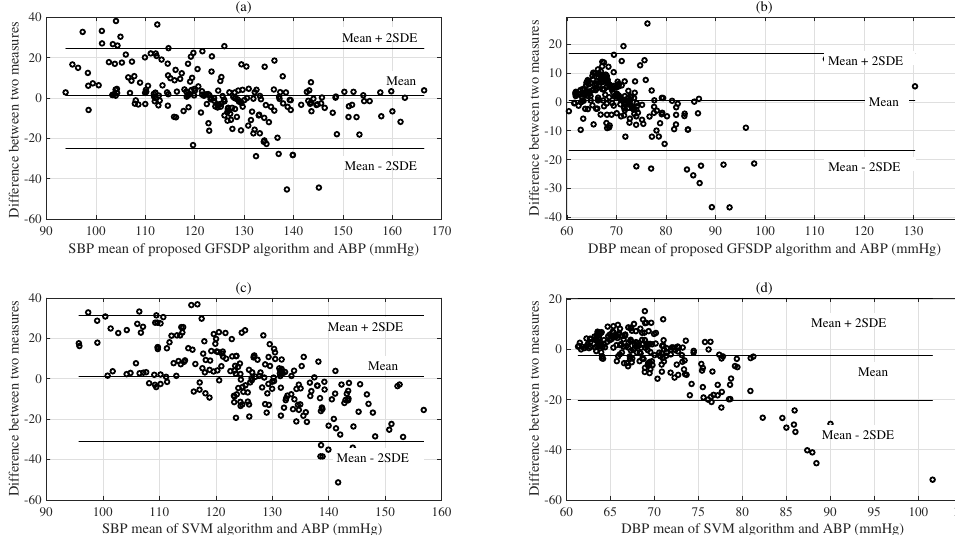
Figure 5. We compared the performance between the proposed GFSDP and the reference ABP for the SBP ( a ) and DBP ( b ). We also compared the performance between the SVM and the reference ABP for the SBP ( c ) and DBP ( d